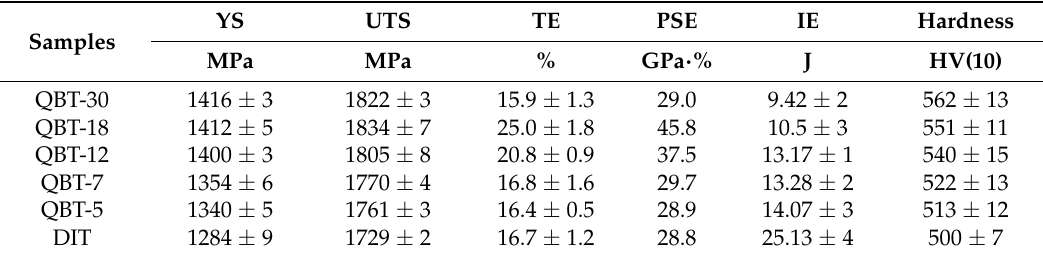
Figure 9. ( a ) Engineering stress–strain curves and ( b ) corresponding instantaneous work hardening exponent as a function of the true stain curves of the investigated steel after isothermal treatment at 300 °C for 4 h. Table 2. Summary of mechanical properties of DIT and QBT samples obtained from various tests performed at room